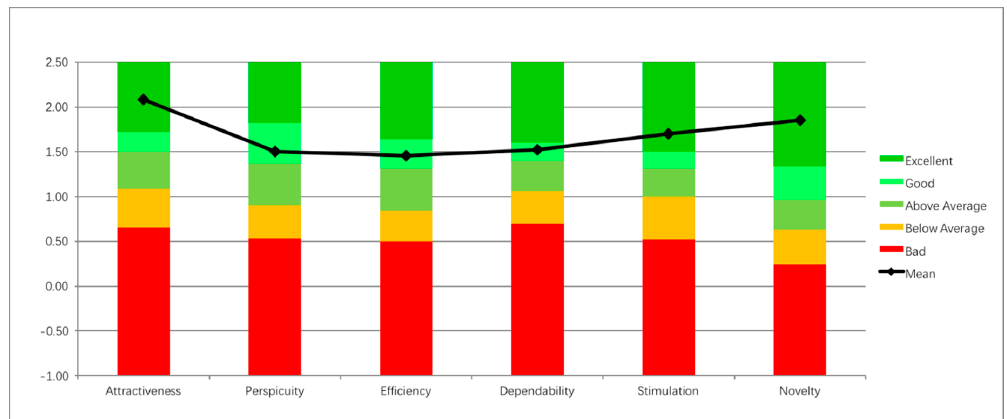
Figure 10. Benchmarking with other products tested with the UEQ questionnaire provides excellent or positive results along all subscales.